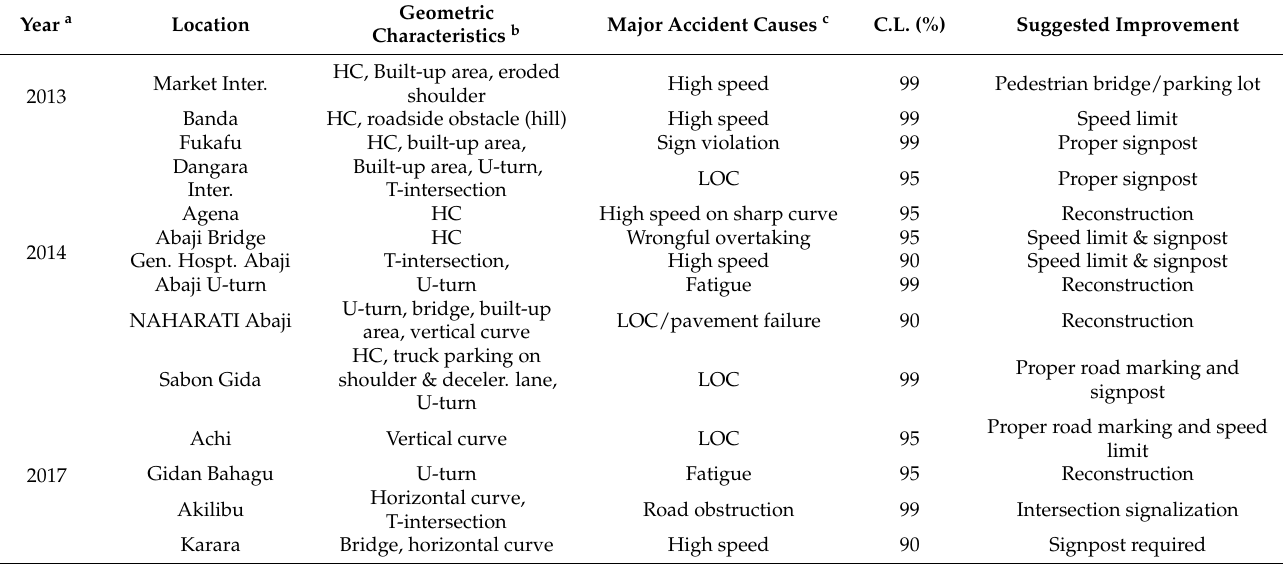
Table 6. Geometric characteristics of the hotspots identified for different